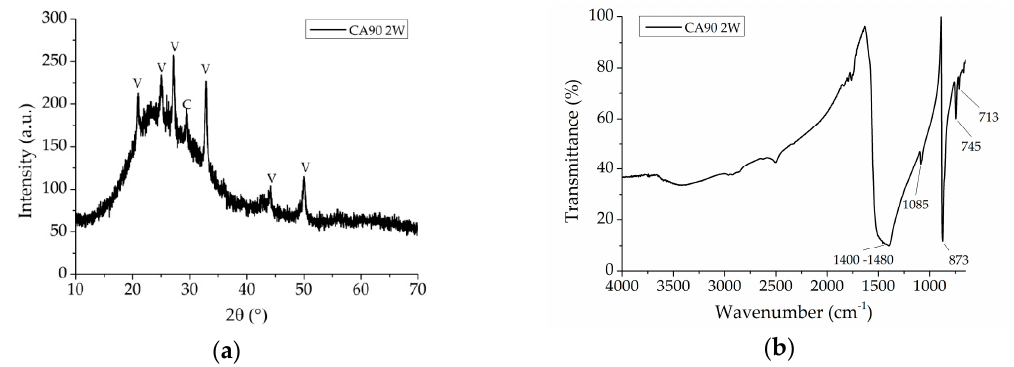
Figure 6. CaLoSilE50 at 90% RH after two weeks (CA90 2W): ( a ) XRD pattern; ( b ) μ FT-IR spectrum. XRD peak assignments: C, calcite; V, vaterite.